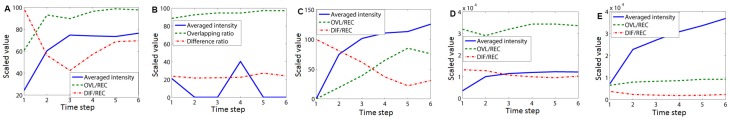
Overlapped volume image based on hybrid classification of imaged tumours and the FCM classified ES images associated with the fifth time frame for case I.(A) Overlapped tumour segments at the first imaging layer. (B) and (C) Overlapped tumour segments randomly selected from two imaging layers. (D) Overlapped tumour segments reconstructed from the last imaging layer.